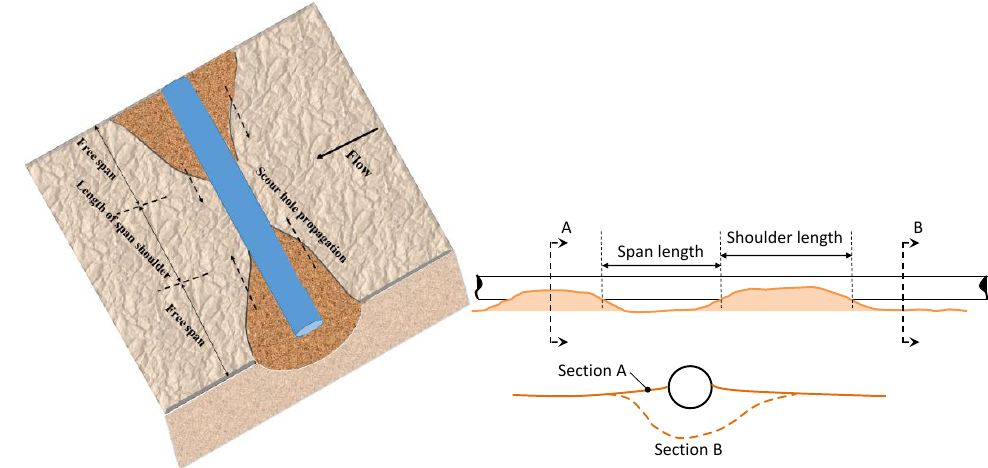
Figure 1. Schematic drawing of 3D scour hole propagation with free span expansion at a submarine pipeline (on the left ); longitudinal and cross-section (i.e., Section A and Section B) views for a submarine pipeline prone to scour (on the right ).